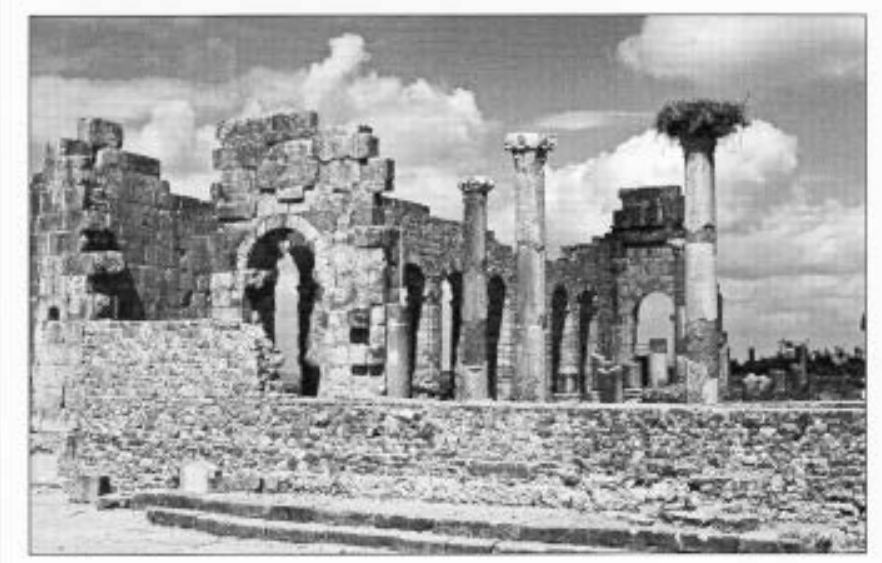
Figure 6 The Roman basilica at Volubilis, viewed from the